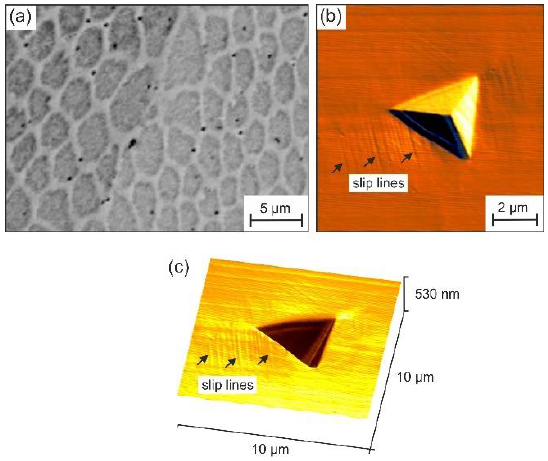
Figure 18. Images of the LMD specimen: ( a ) BSE image of the etched cellular substructure, ( b ) top-view AFM image of an indentation imprint with parallel slip lines in the plastic zone next to the imprint, and a ( c ) 3D visualization of the indentation imprint with parallel slip lines in the plastic zone next to the imprint.